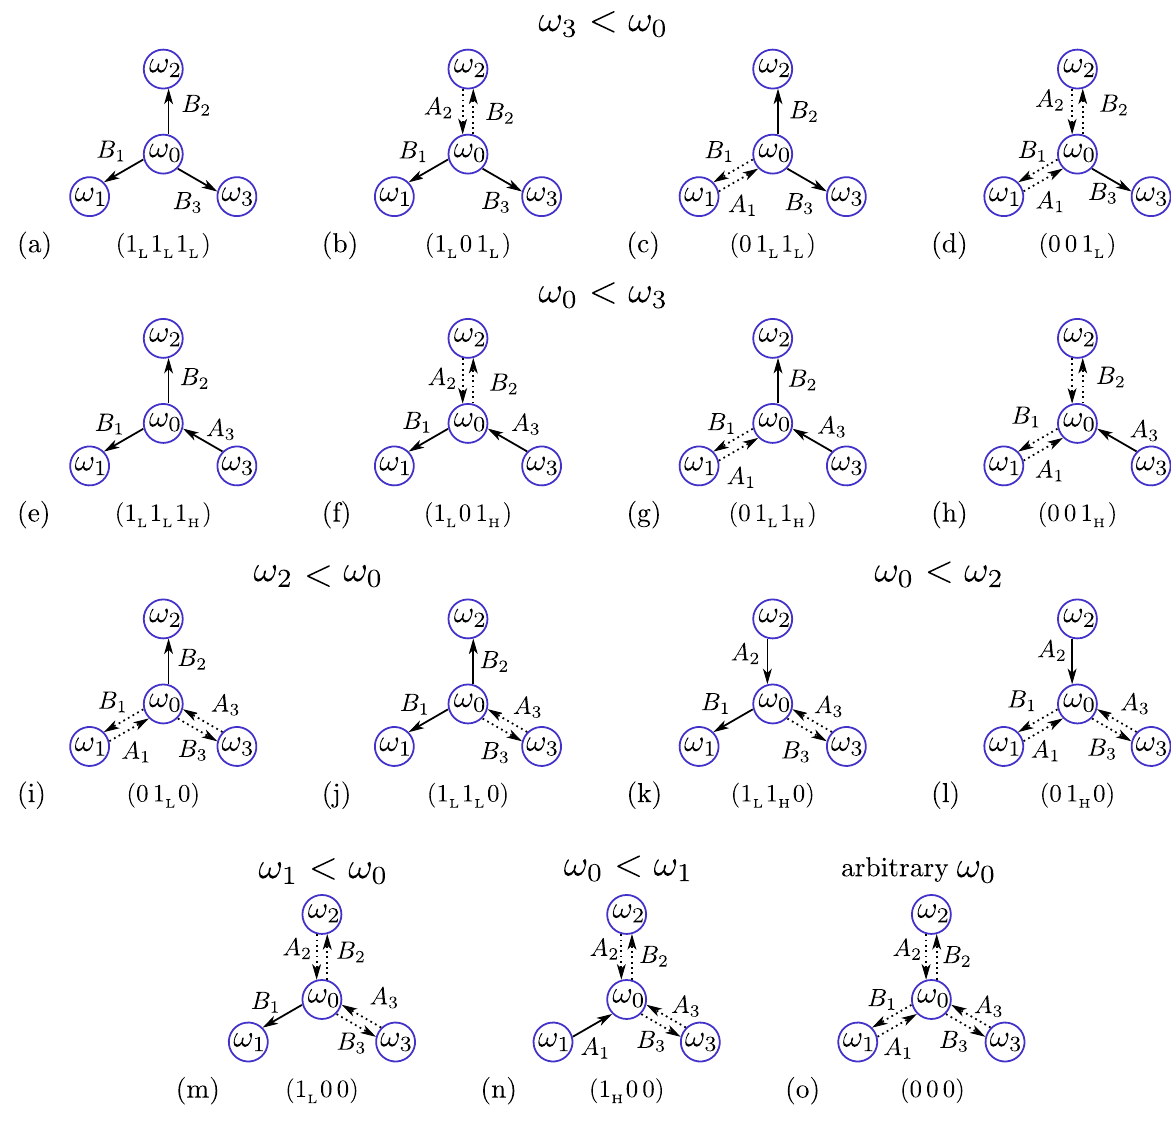
Figure 5. ( a-o ) Possible asymptotic configurations for a three-leaf star network. See capture to Fig. 4 for details. ω 0 < ω